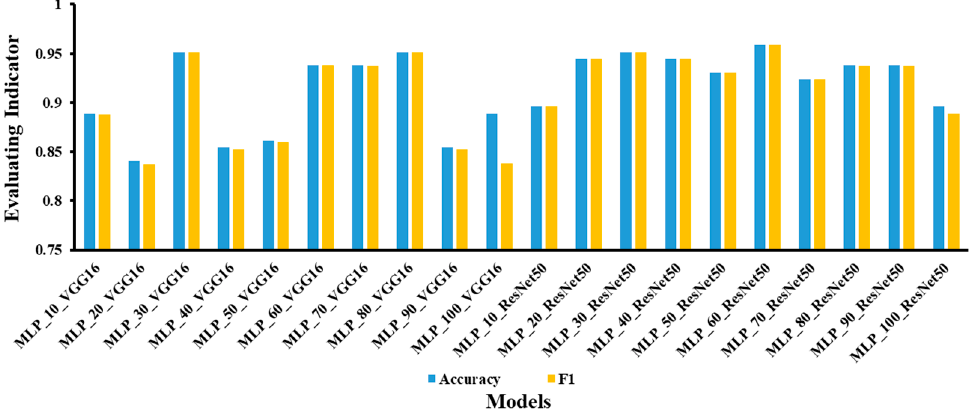
Figure 8. MLP model built with ten sets of hidden layer node numbers with VGG16 and MLP_Res- Net50 fusion modeling of accuracy and F1.